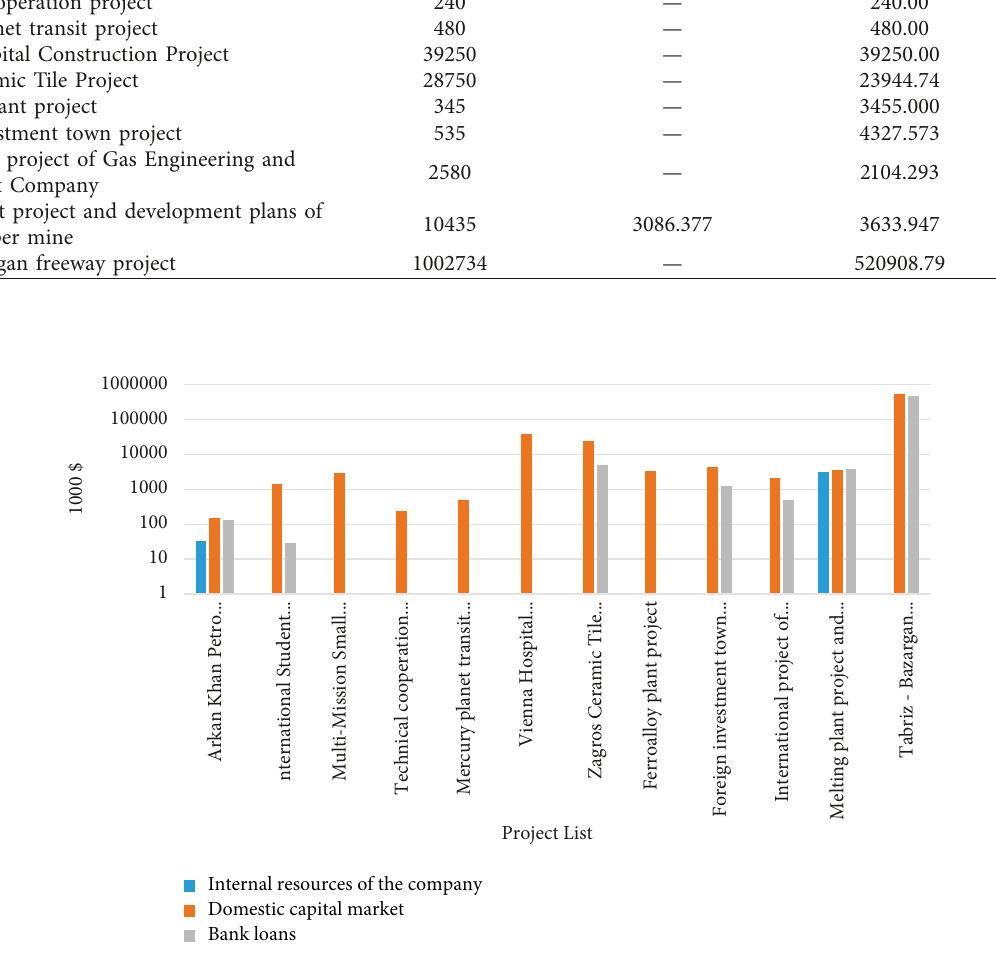
Figure 6: Amount of financing for international projects from different